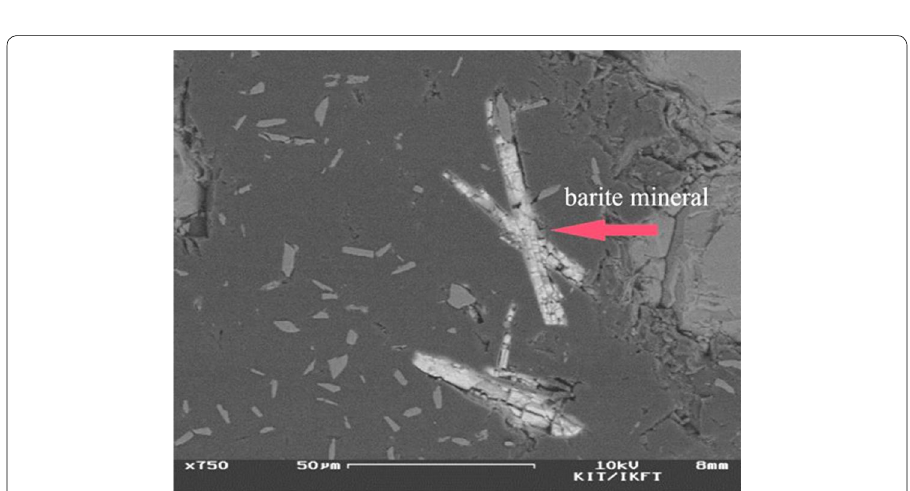
Fig. 11 Intergrowth of barite, sample 7.2 (PV07; 60 °C/20